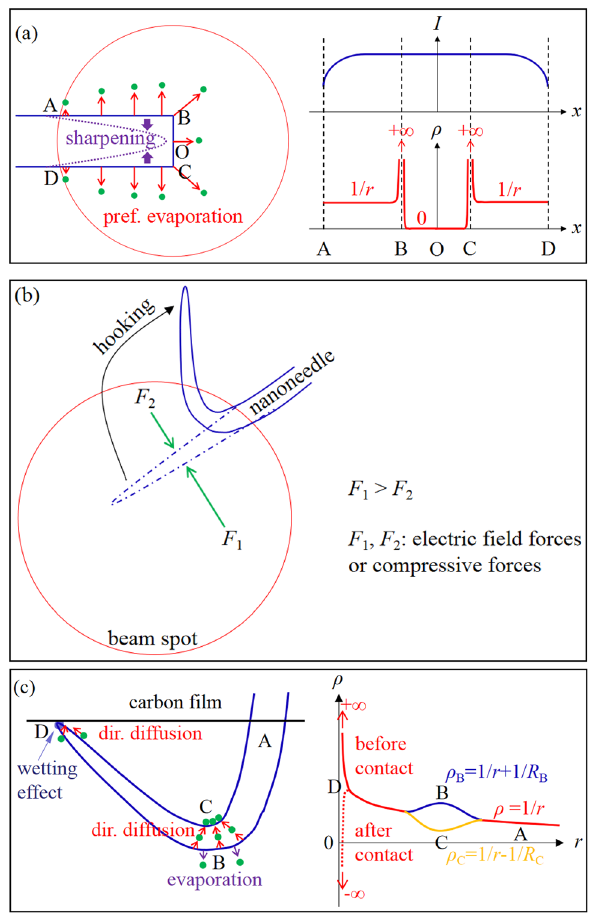
Fig. 4 Schematic diagrams showing the mechanisms of a sharp- ening, b hooking, and c welding of SiO under energetic e-beam